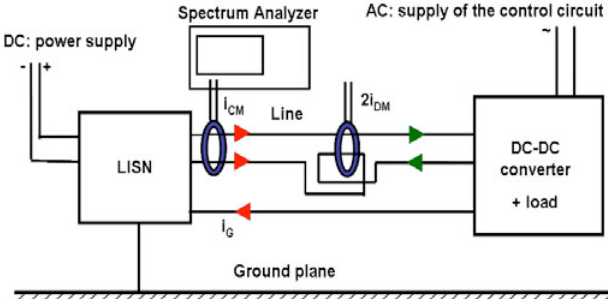
Figure 4: Method using current probes. The measured CM and DM currents are shown in figure 5. The determination of attenuation required is obtained making the difference between the measured currents and the limit given by the EMC standards. Thus, attenuation requirements for the two modes are shown in figure 6.